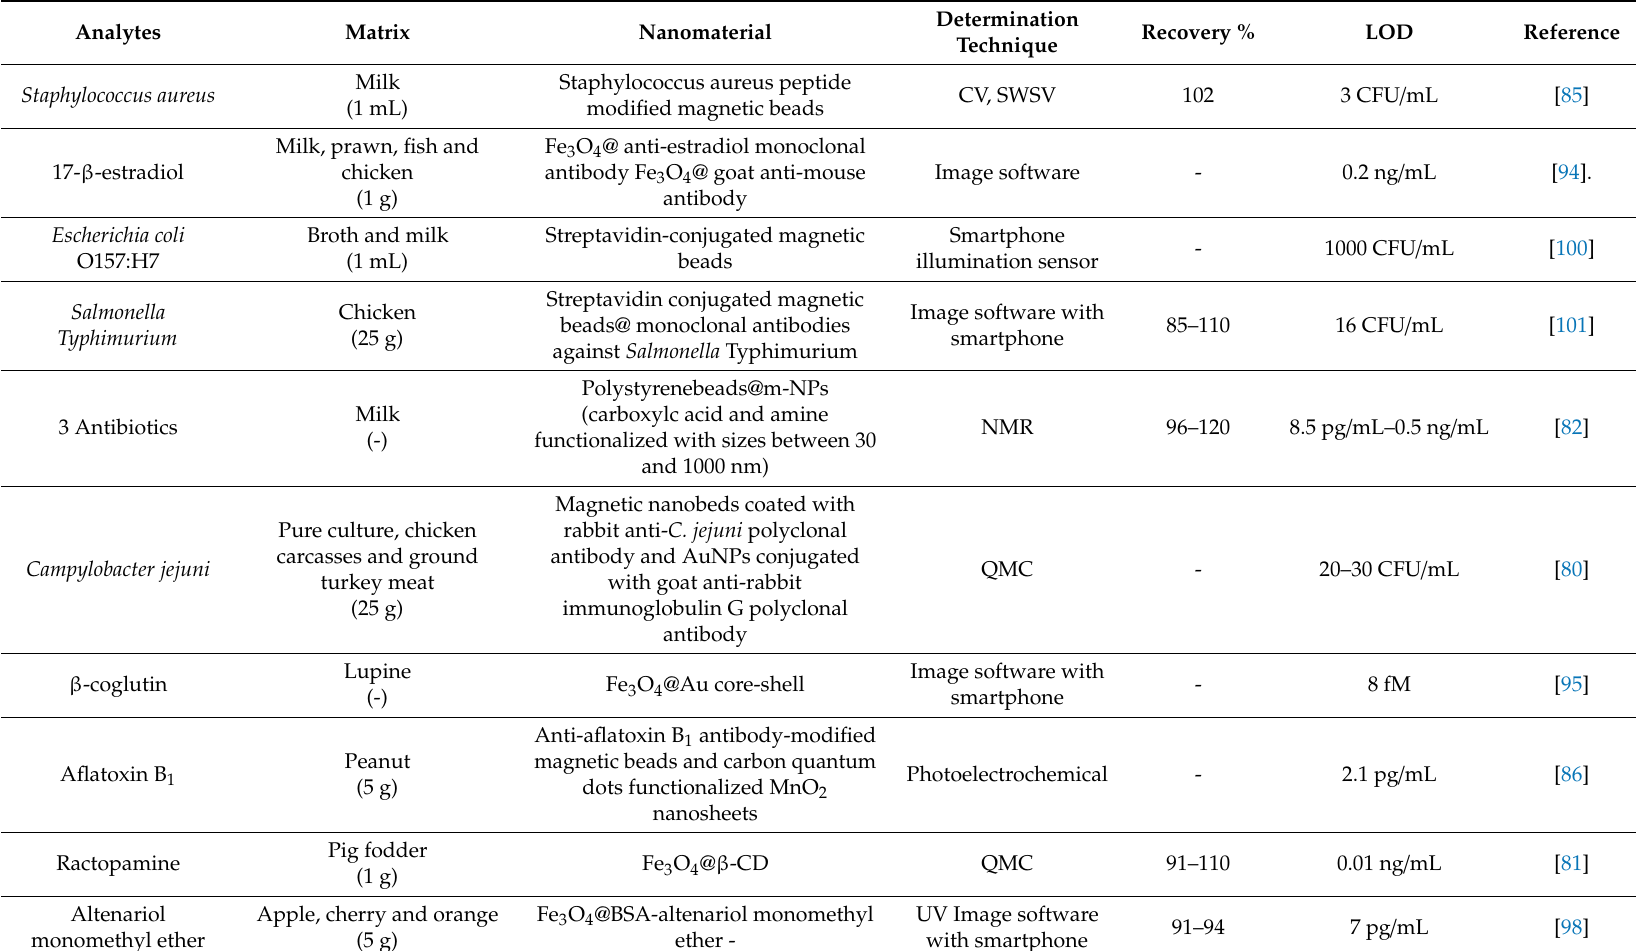
Table 6. Novel applications of magnetic nanoparticles in other kinds of